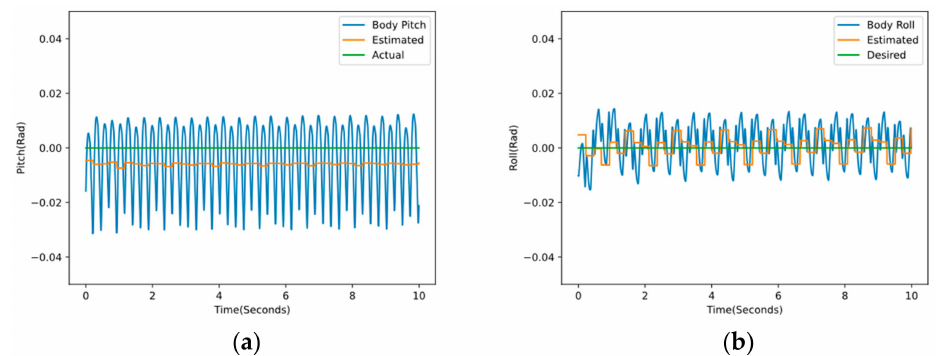
Figure 12. Changes in the attitude angle of the robot. ( a ) Changes in the pitch angle of the robot. ( b ) Changes in the roll angle of the